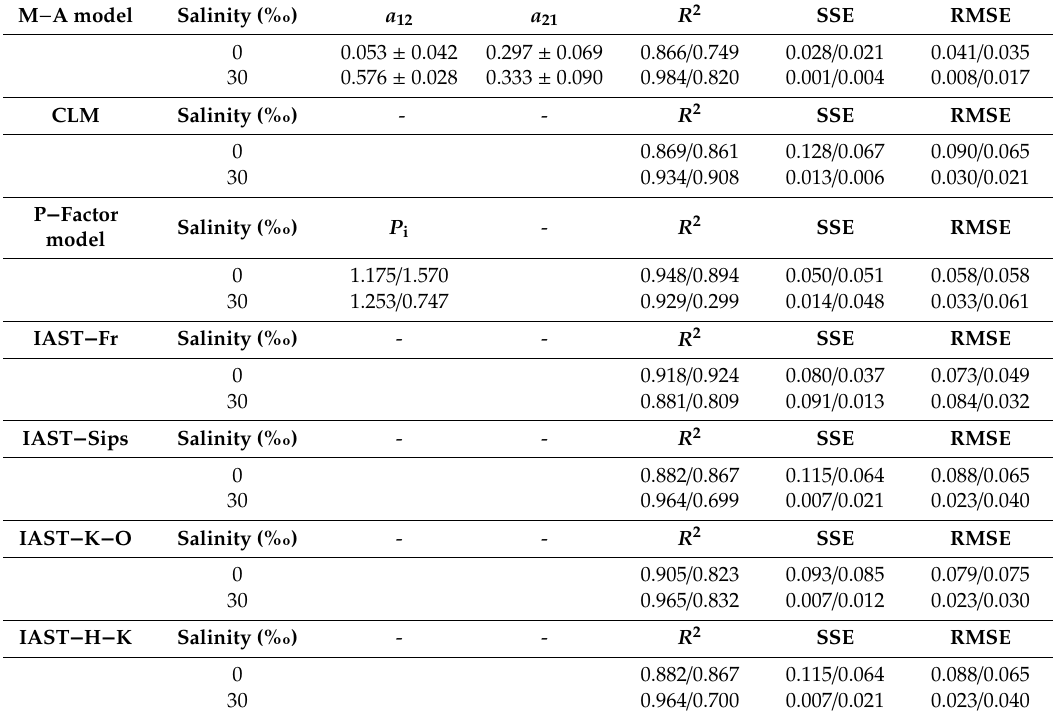
Figure 4. Binary adsorption of Ni and Zn onto PINM at di ff erent salinities (pH = 5.0). ( a ) 0% (cid:24) and ( b ) 30% (cid:24) . Lines represent model predictions. Table 5. M-A model, CLM, P-factor model and IAST coupled to single adsorption model parameters for binary adsorption of Ni(1) and Zn(2) onto PINM at pH